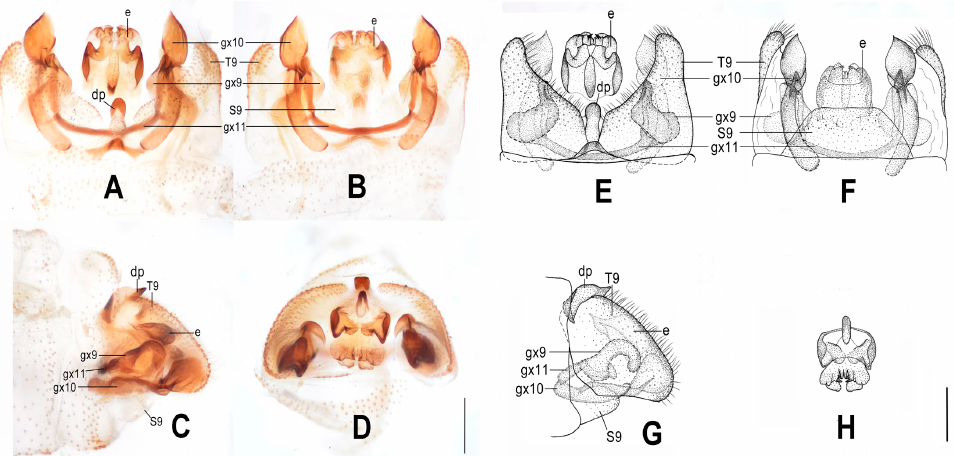
Figure 6. Dilar forcipatus sp. nov. ( A – D ) male holotype, genitalia, photographs: ( A ) dorsal view; ( B ) ventral view; ( C ) lateral view; ( D ) caudal view. ( E – H ) male holotype, genitalia, line drawings: ( E ) dorsal view; ( F ) ventral view; ( G ) lateral view; ( H ) ectoproct, caudal view. dp: dorsoprocessus; e: ectoproct; gx9: gonocoxite 9; gx10: gonocoxite 10; gx11: fused gonocoxites 11; S9: sternum 9; T9: tergum 9. Scale bars: 0.2 m.